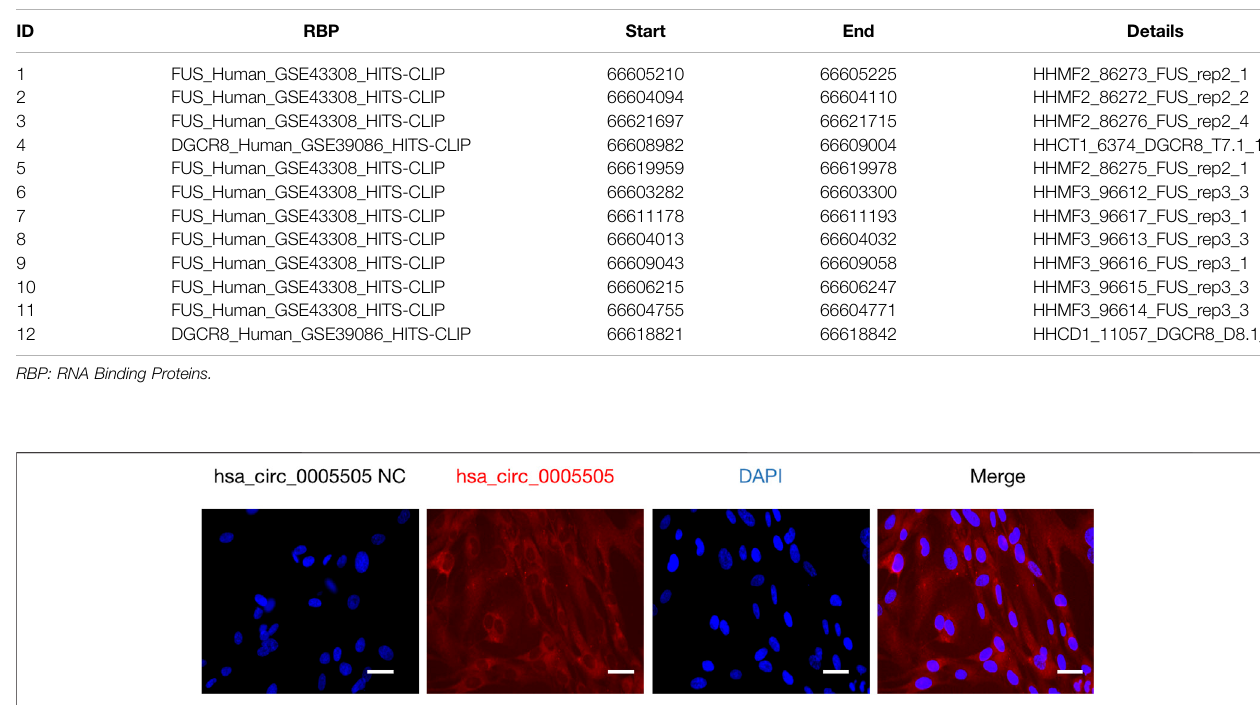
TABLE 2 | Proteins binding on hsa_circ_0005505.